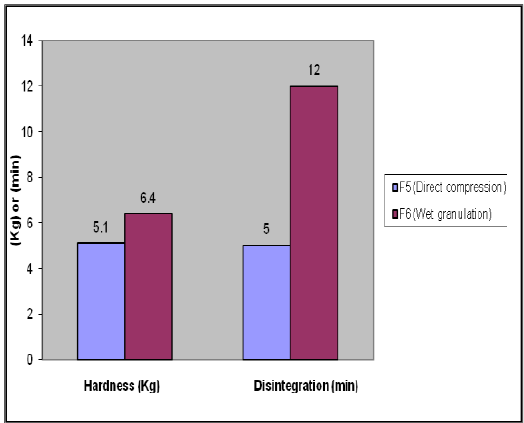
Figure 4: Effect of different type of diluent on the hardness and disintegration time of formulas F1 (Mannitol) and F7 (Lactose) Bisoprolol tablets .